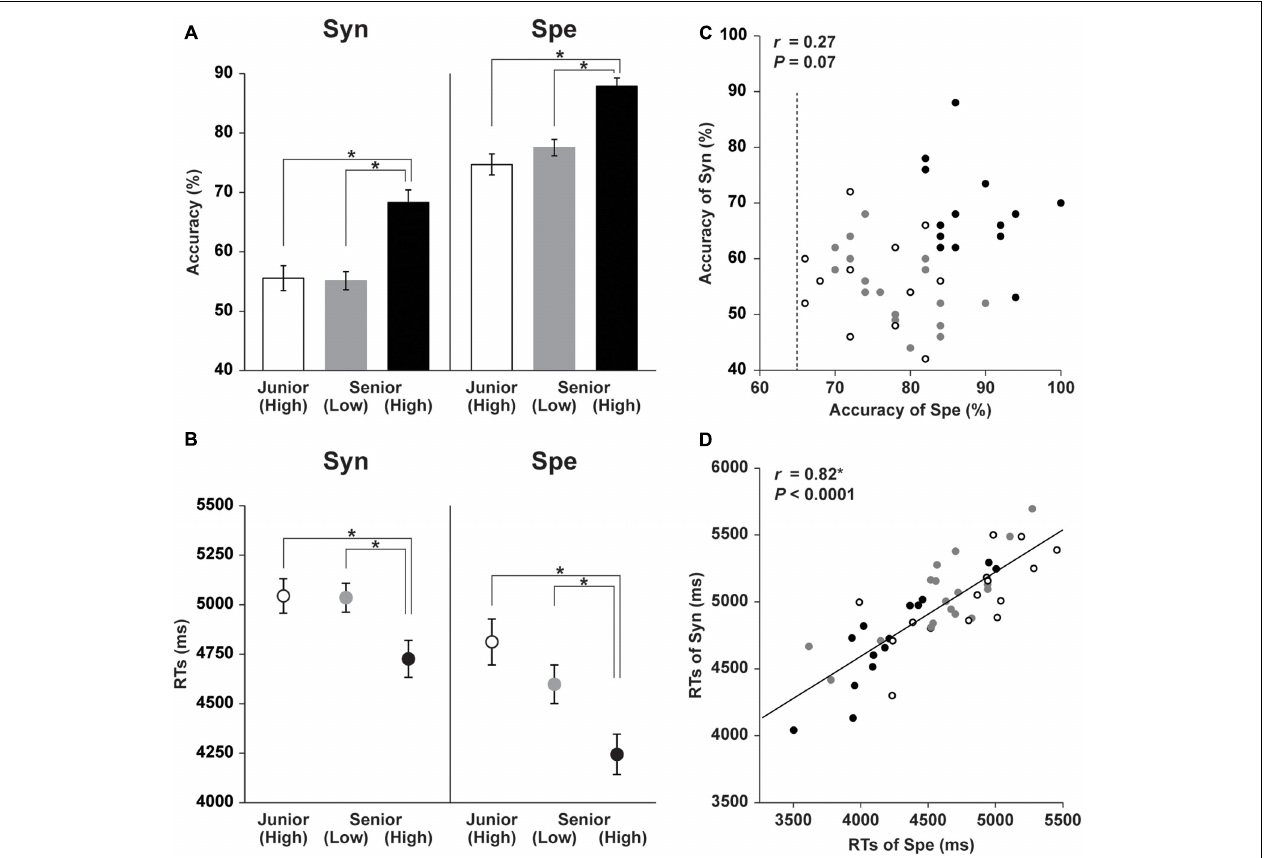
FIGURE 1 | Behavioral data of Syn and Spe tasks for the three groups. (A) The accuracy of Syn and Spe tasks for the three groups of high school students, Junior (High), Senior (Low), and Senior (High), are indicated by bars with white, gray, and black shades, respectively. Error bars indicate the standard error of the mean (SEM) for the participants, and asterisks denote the significant differences (Bonferroni-corrected P < 0.05). (B) The reaction times (RTs) of the Syn and Spe tasks for the three groups are indicated by dots corresponding to the white, gray, and black shades in (A) . The Senior (High) group showed significantly higher L2 abilities, i.e., higher accuracy and shorter RTs, while the Junior (High) and Senior (Low) groups showed no significant difference in the accuracy or RTs in either task. (C,D) Independence of the accuracy of the Syn and Spe tasks. Individual behavioral parameters were plotted to compare the two tasks, as shown by the plotted dots, whose groups correspond to the shades in (A) . The dotted line indicates an inclusion criterion of Spe. The accuracy of Syn and Spe showed no significant correlation (C) , while the RTs of Syn and Spe were highly correlated (D) .